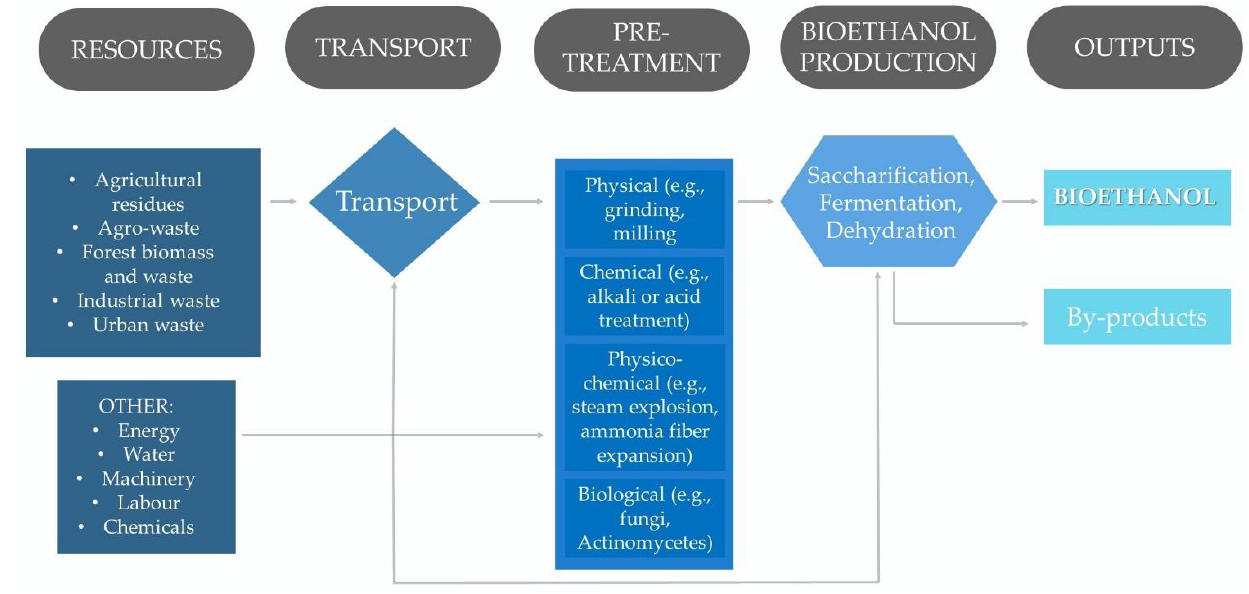
Figure 3. Five elements of bioethanol production, including resources, transportation, all stages of processing and conversion technologies with associated inputs, and final products (based on [3,30]).